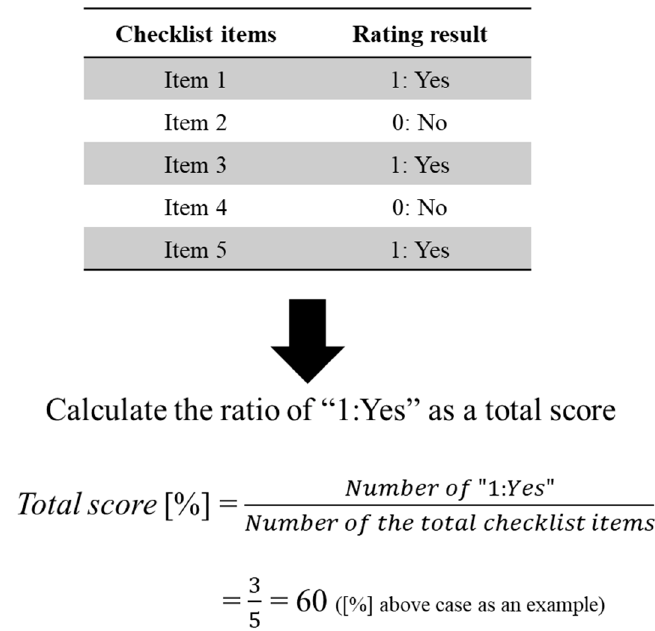
Figure 2. Calculation of usability score by proposed task flow-based usability checklist.